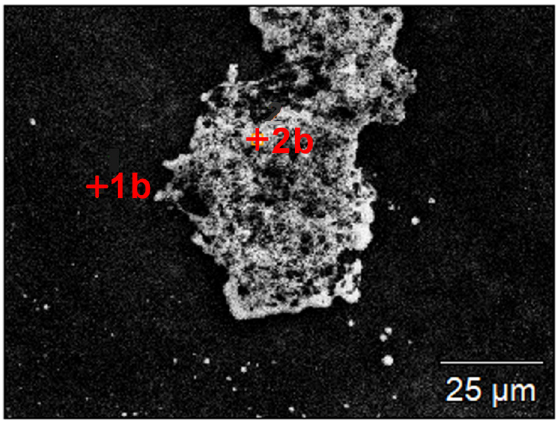
Figure 2. Morphology of the: ( a ) leachate, ( b ) control solution, SEM (SE).